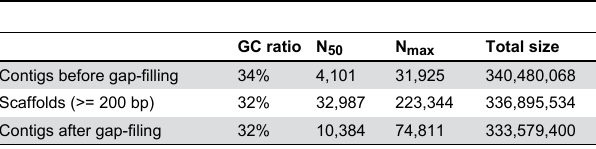
Table 1. Summary of Anisogramma anomala genome assembly using SOAPdenovo